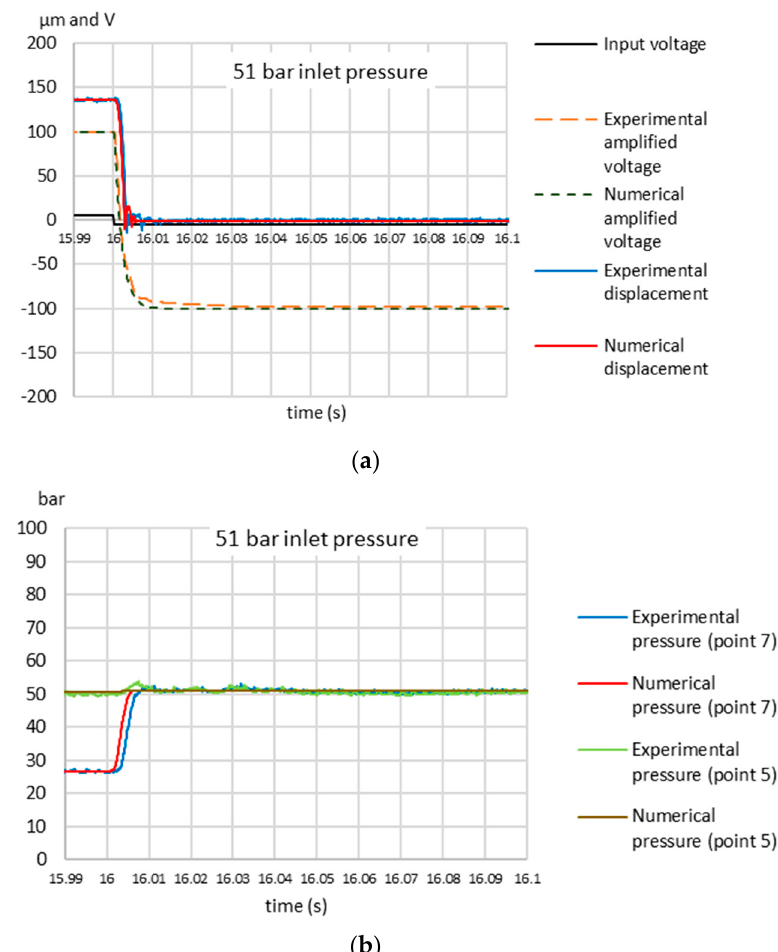
Figure 9. Test 5 (51 bar supply pressure). Comparison between measured amplified voltage and simulated one and between measured displacement and simulated one for a negative step control voltage (input voltage to the amplifier) from + 5 V to − 5 V: ( a ); comparison between measured pressures and simulated ones: ( b ) .